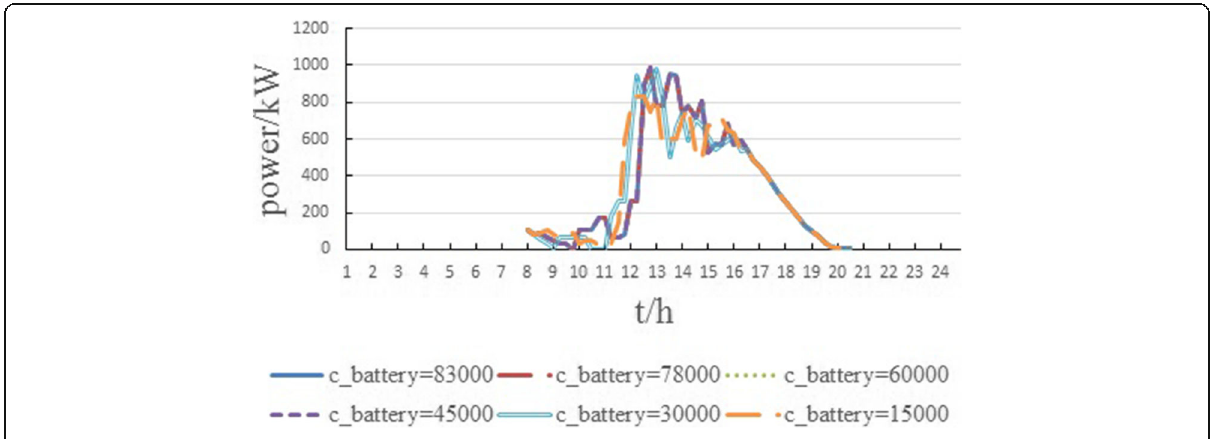
Fig. 11 PV consumption power curves with different battery costs at a workday in Summer (PV capacity = 1000 kW)